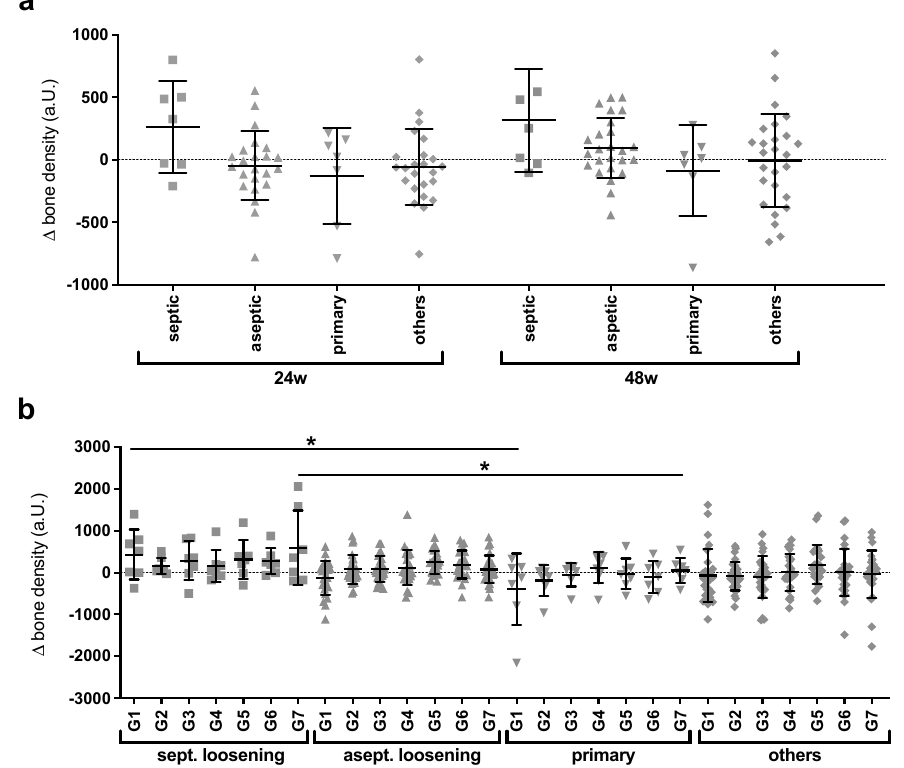
Figure 4. ( a ): Average ∆ -density of subgroups after 24 and 48 weeks; ( b ) average G1 to G7 of subgroups after 48 weeks. Different quantitative adjustment characteristics emerged for the four subgroups, and the method detected significant differences (* p < 0.05) between the two subgroups septic loosening and primary for both zones G1 and G7. There was, in total, a large increase in bone density after septic causes, in contrast to a small decrease after primary stem implantation, and no consistent trend for the subgroups aseptic loosening and others. Even subdivided into the Gruen zones, there was no uniform adaptation behavior, and the cases were very individual. Nevertheless, it can be observed again that the largest variations were observed in the two proximal zones.